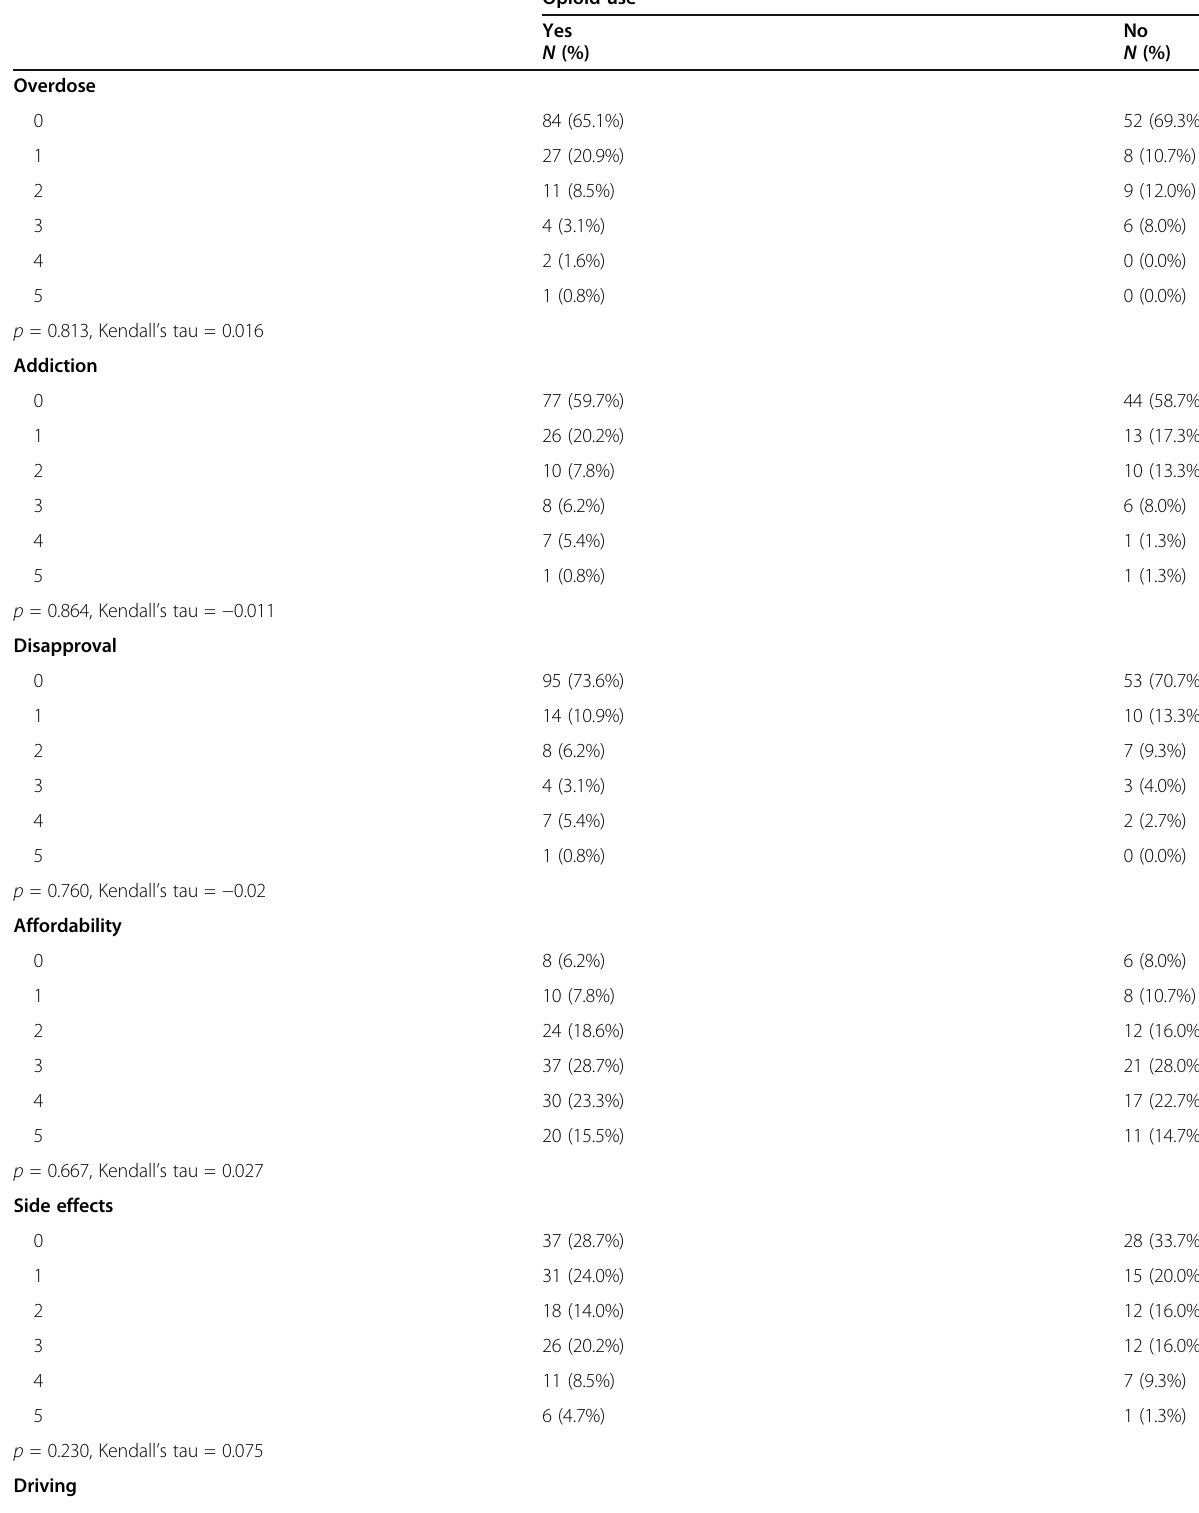
Table 7 Associations between opioid use and concerns ( n =